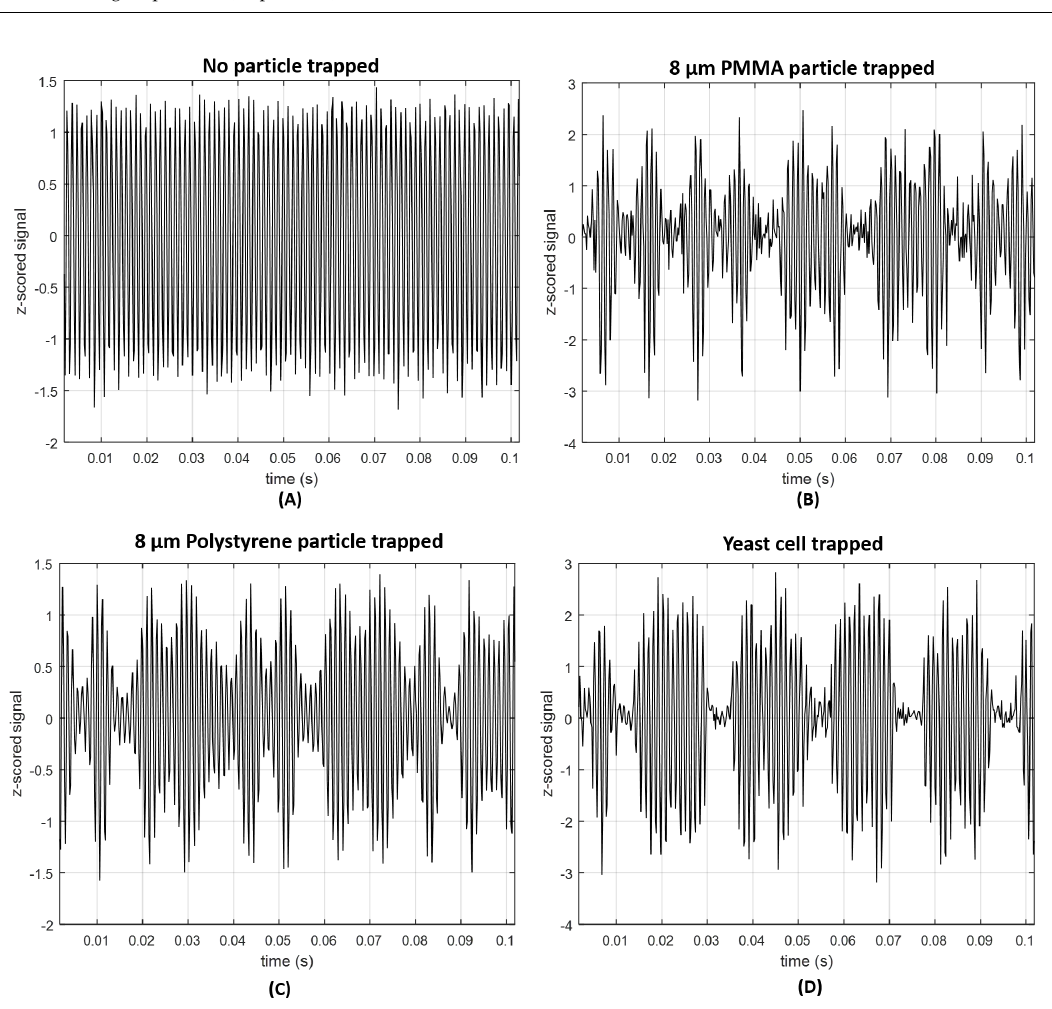
Figure 6. Portion of back-scattered signals obtained after signal processing steps for ( A ) “no particle trapped”, ( B ) “PMMA particle trapped”; ( C ) “Polystyrene particle trapped" and ( D ) “Living yeast cell